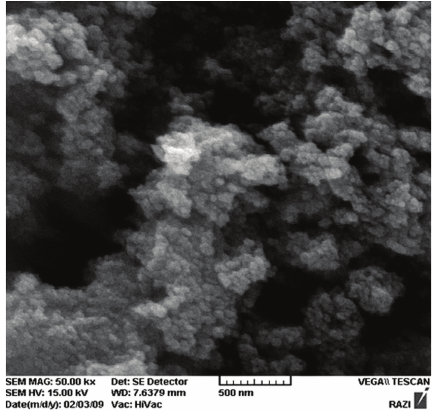
F 1: SEM photograph of 9-acridinylamine modi�ed nano